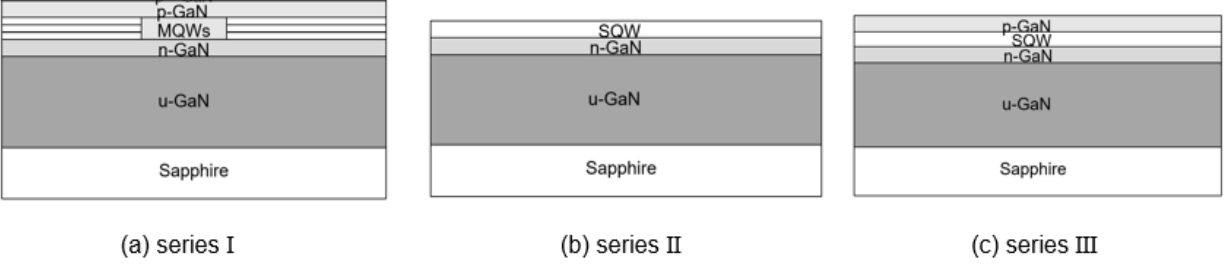
Figure 1. Schematic diagrams for InGaN/GaN MQW (series I) and SQW (series II/III) samples.